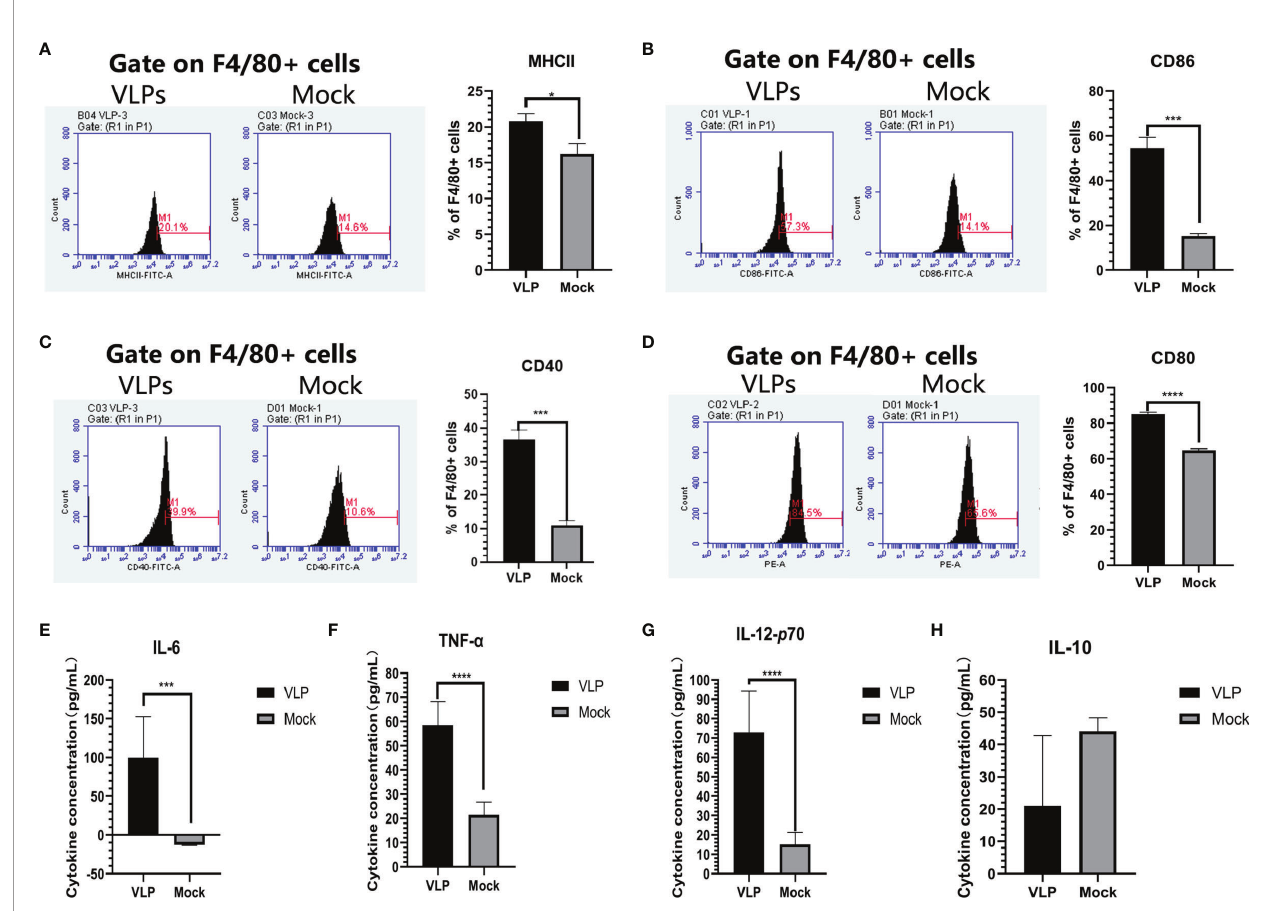
FIGURE 5 | Analysis of macrophage activation in response to VLPs. Cultured macrophage isolated from murine bone marrow were treated with PBS (Mock) or VLPs (10 m g) for 48 h respectively. Thereafter, fl ow cytometry was used to compare the percentages of F4/80+ macrophage expressing MHC-II (A) , CD80 (B) , CD40 (C) and CD86 (D) . In parallel, culture supernatants were harvested to measure the secreted levels of IL-6 (E) , TNF- a (F), IL-12p70 (G) and IL-10 (H) . All experiments were performed independently at least thrice and results were presented as means ± standard deviation. Signi fi cance levels were de fi ned as *p < 0.05, ***p < 0.001 and ****p <